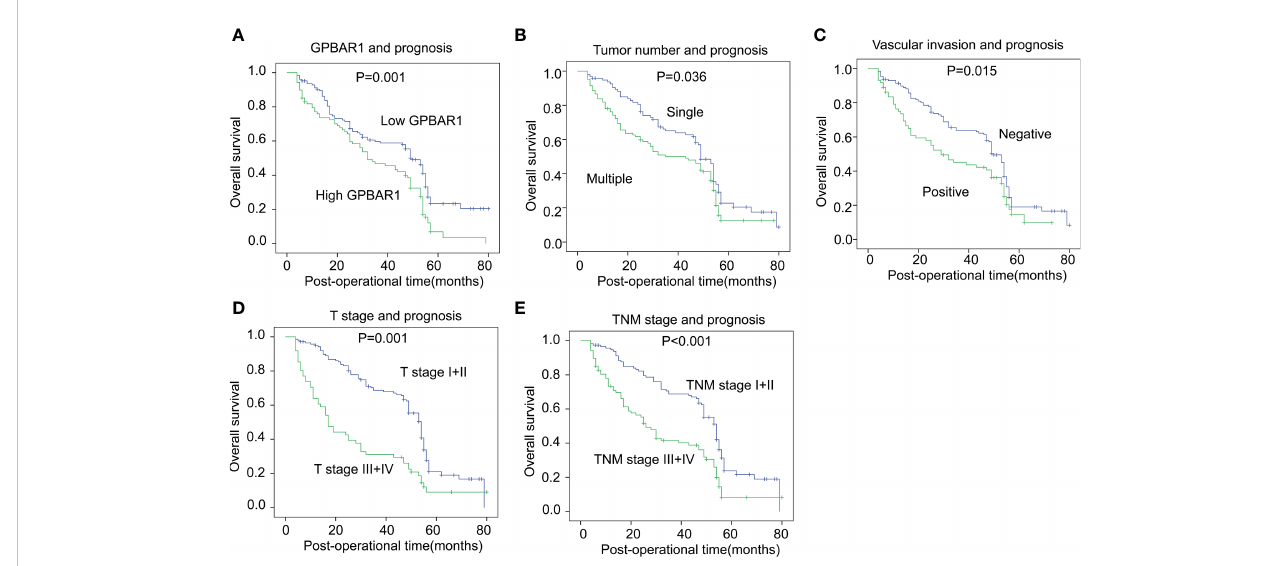
FIGURE 2 The correlation between GPBAR1 and OS rates. The cohort was divided into subsets according to different parameters. High GPBAR1 (A) , multiple tumor numbers (B) , positive vascular invasion (C) , advanced T (D) , and TNM (E) stage were all signi fi cantly associated with poor prognosis. The statistical signi fi cance is analyzed by a log-rank test.